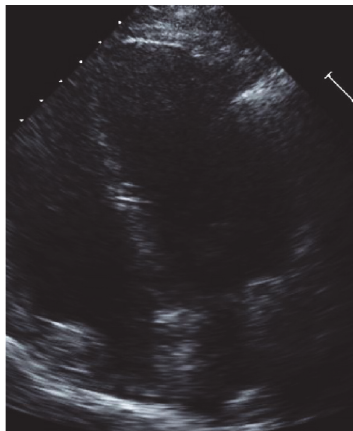
Figure 3: Preoperative TTE, end systole (preop pics).